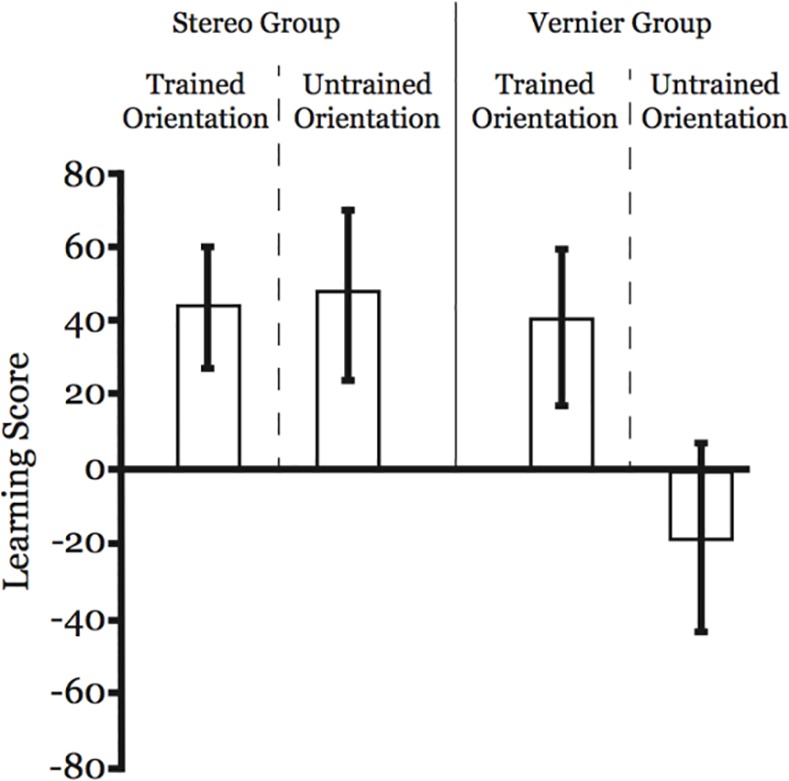
Learning and orientation transfer data.Both the stereo and vernier trained groups significantly improved their performance on their respective trained task/orientation combinations (left panel for each). However, while the vernier trained group showed evidence of clear orientation specificity (i.e. no improvement on the untrained orientation–far right panel), this was not the case for the stereo group, where the amount of improvement in the untrained orientation was similar to that seen for the trained orientation. *Error bars reflect 95% CI